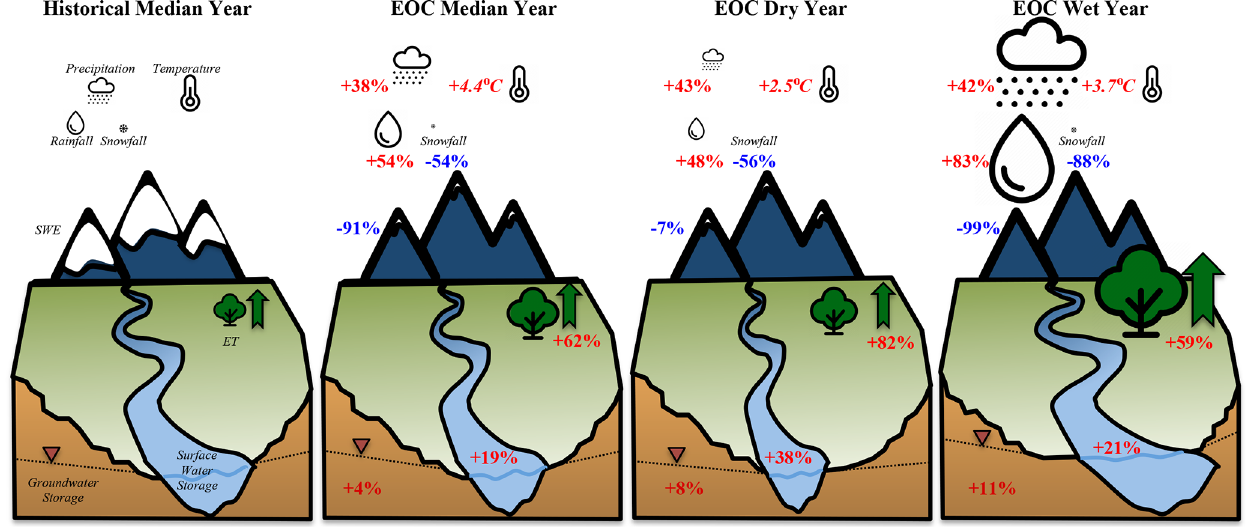
Figure 4. Annual percent changes in precipitation, rainfall, snowfall, temperature, SWE, ET, surface water, and groundwater storages in the EoC water years (WYs) (i.e. median, dry, and wet) at the watershed scale relative to their historical counterparts. Infographic size scaled to EoC